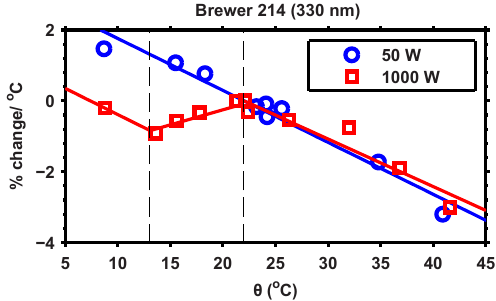
Figure 1. Changes in the response of B214 at 330nm, relative to the response at 25 ◦ C for the same wavelength, as a result of changes in temperature, derived using 50 and 1000W tungsten halogen